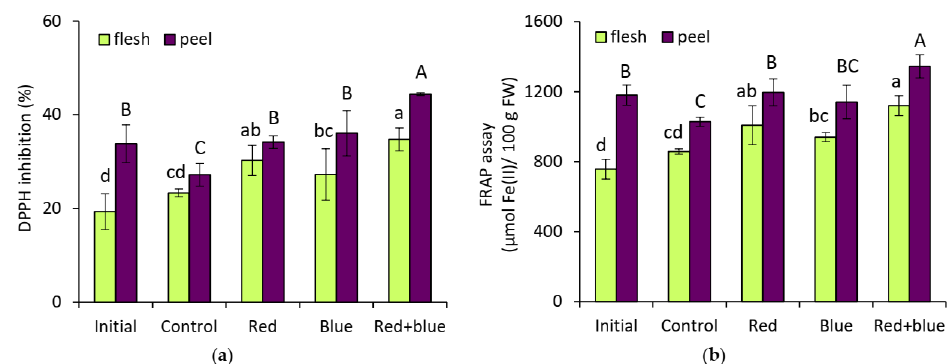
Figure 3. Effect of different LED lights on antioxidant activity: ( a ) DPPH inhibition and ( b ) FRAP assay of eggplants. Different letters a–d and A–C indicate statistically significant differences ( p < 0.05) according to Duncan’s multiple range test of flesh and peel, respectively. Error bars show means ± SD ( n = 3). Table 2. Gallic and chlorogenic acid contents of eggplants after LED postharvest treatment. Plant